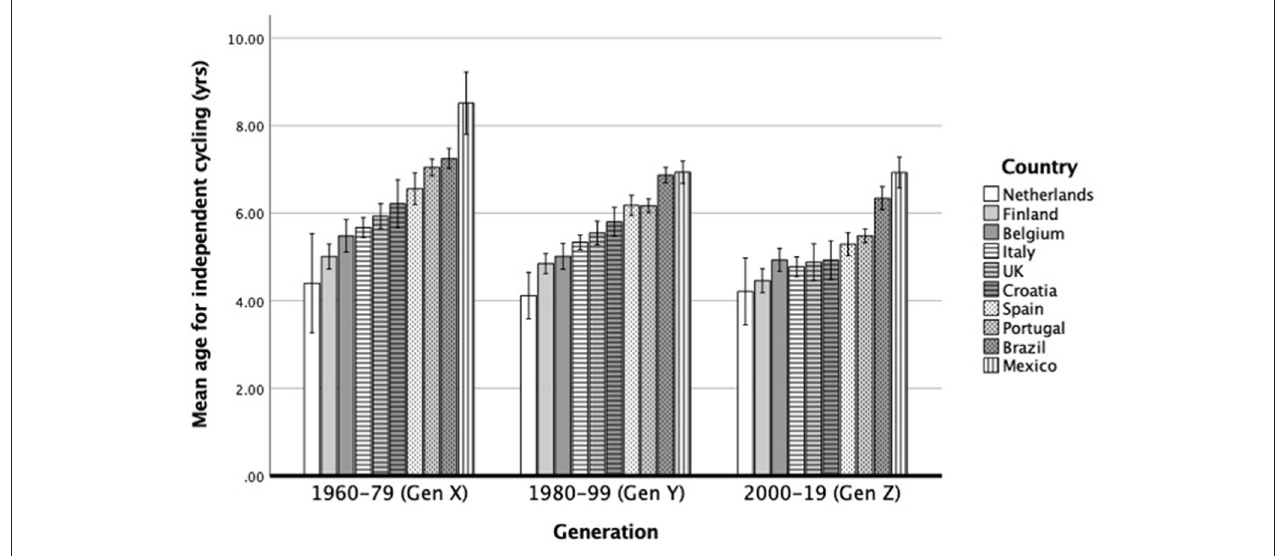
FIGURE 3 | Mean age to learn how to cycle independently by generation and country. Error bars represent 95%